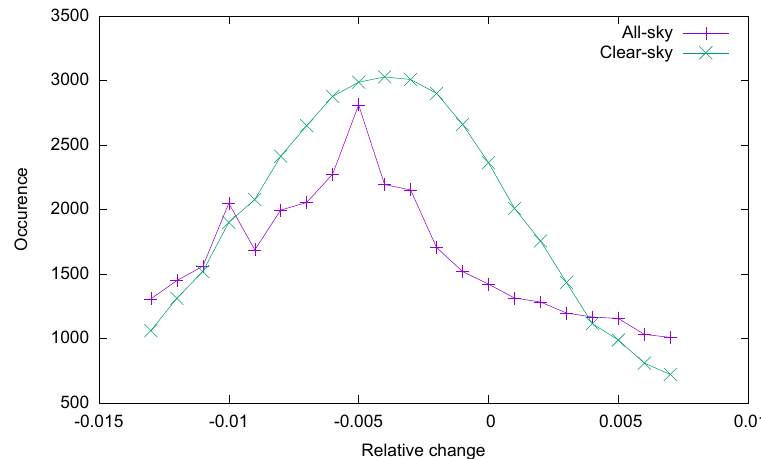
Figure 6. Histogram of relative changes from 08/2000–07/2009 to 08/2009–07/2018 of the all-sky (green curve) and clear-sky (purple curve) regional 1 ◦ × 1 ◦ Ceres Ebaf 4.0 RSR.